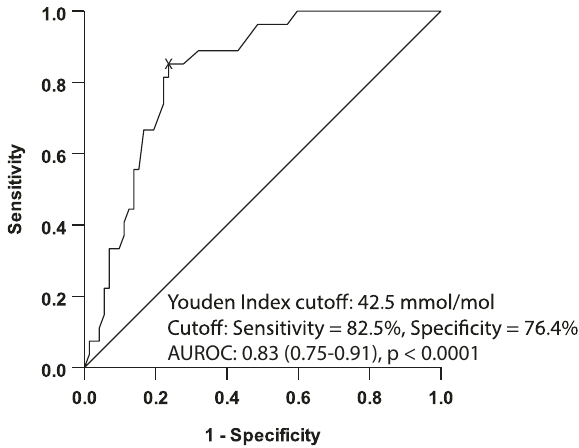
Fig. 4 Receiver-operating characteristic curve of HbA1c concen- trations for a high serum GDF-15 concentration. State variable was serum GDF-15 concentrations <1193.7 pg/ml vs. ≥ 1193.7 pg/ml (0 and 1, respectively). Sample size n =